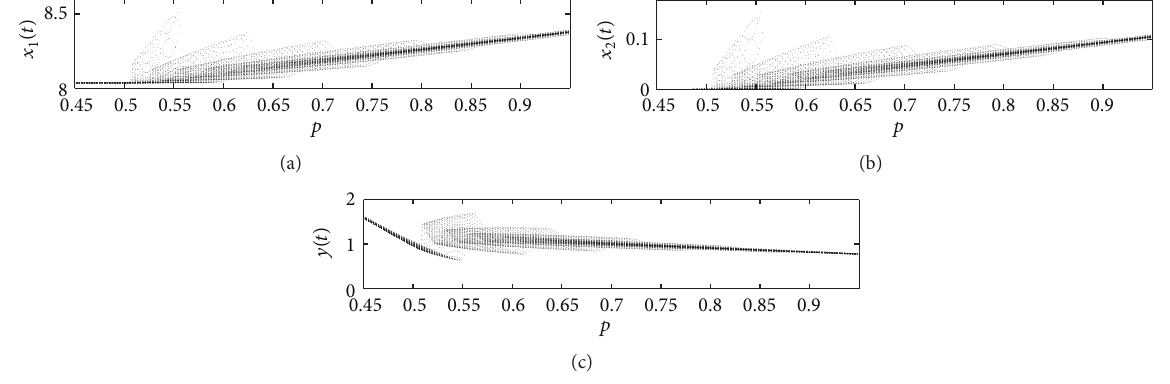
Figure 4: Complex dynamic properties of system (1) with 𝑟 = 3, 𝜏 = 0.5, 𝜔 = 0.2, 𝜇 = 4,𝛽 = 4, 𝑘 = 0.2, 𝑝 0 = 0.1, 𝑑 1 = 0.1, 𝑑 2 = 0.2, 𝑑 3 = 0.15, 𝑎 = 5, 𝑏 = 7 , and 𝑇 = 4 , where killing rate 𝑝 varies from 0.45 to